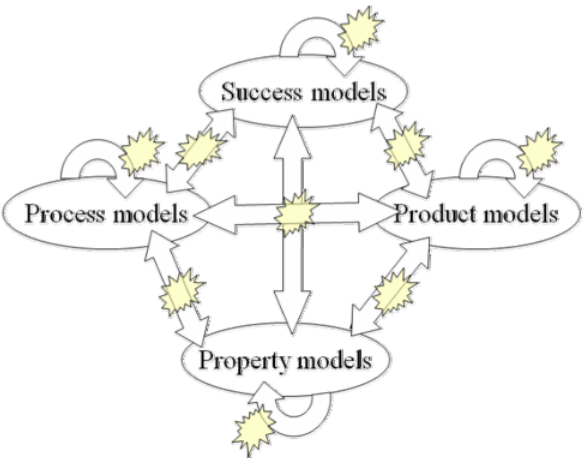
Figure 2. Models and model clashes in software system